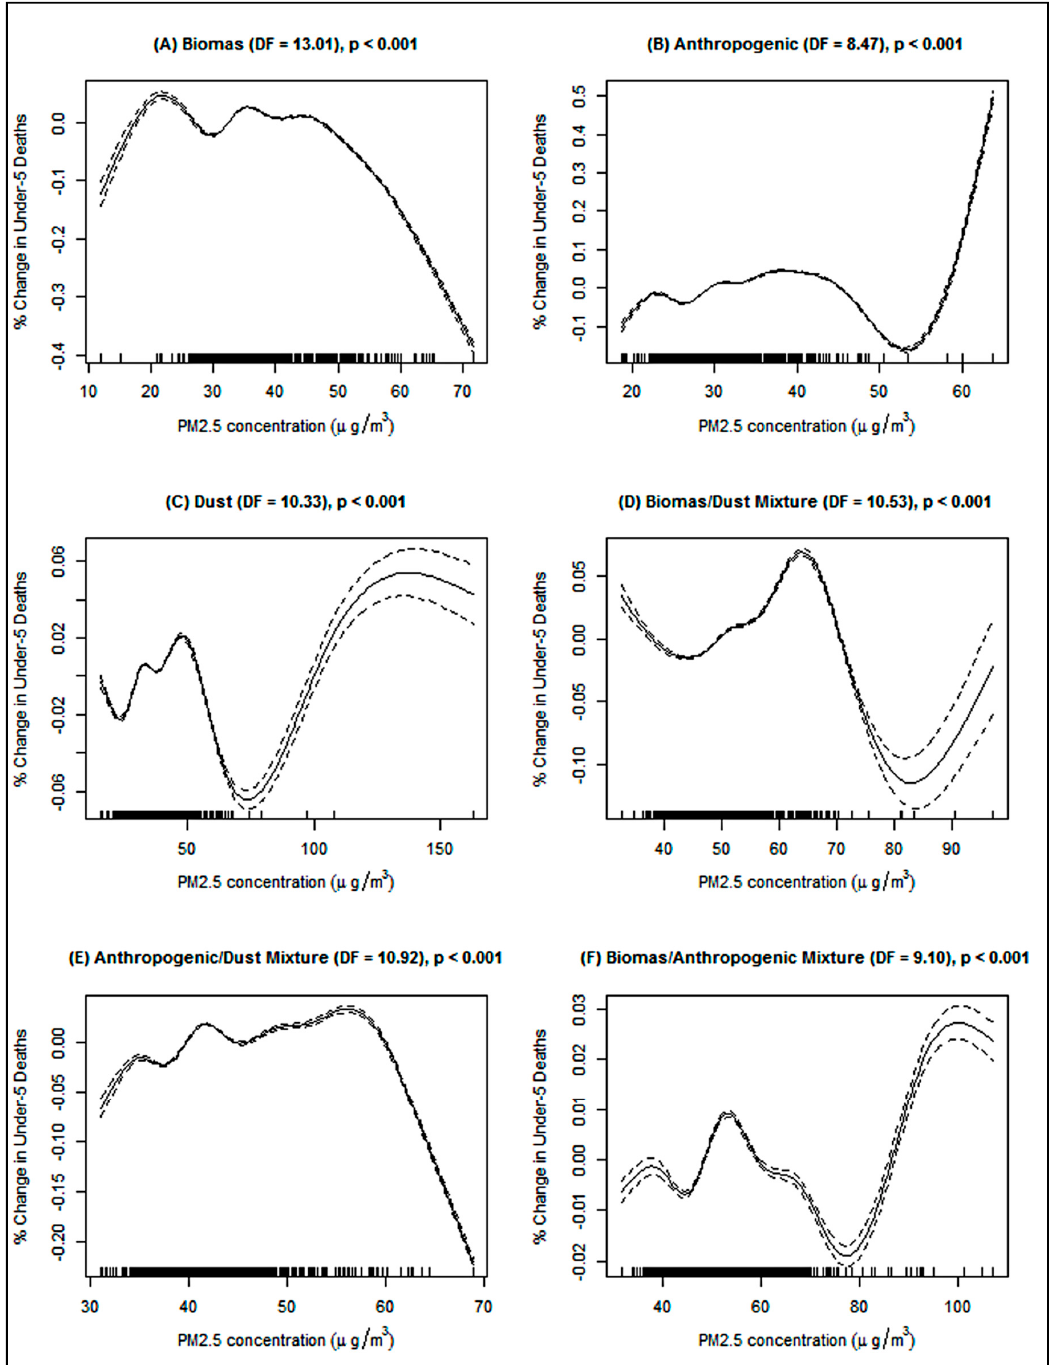
Figure 3. The penalized spline of the association between ambient PM 2.5 concentration and under-five deaths in Asia. ( A ) Biomass PM 2.5 , ( B ) Anthropogenic PM 2.5 , ( C ) Dust PM 2.5 , ( D ) Biomass / dust mixture PM 2.5 , ( E ) Anthropogenic / dust mixture PM 2.5 , and ( F ) Biomass / anthropogenic mixture PM 2.5 . Adjusted for temperature, undernourished population, TB deaths, AIDS deaths, employed population, female population, urban population, total population, year, and country. The dose-response relationship is represented by the solid line while the broken line represents the 95% confidence